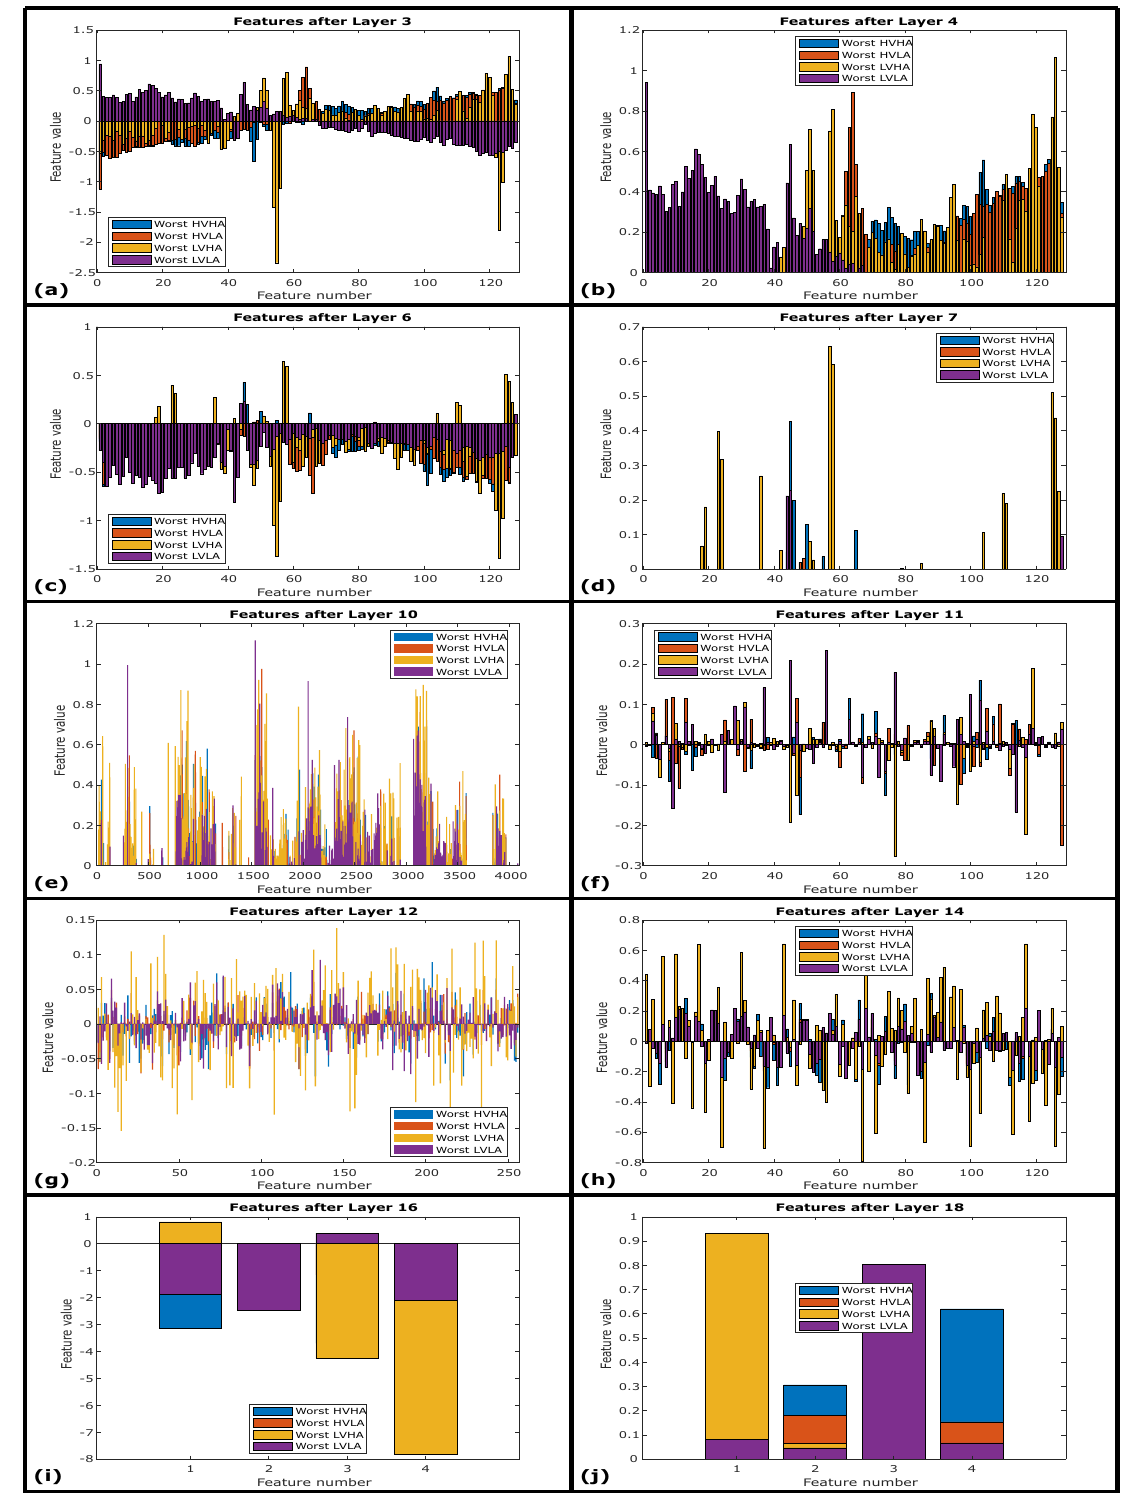
Figure 11. ( a ) Worst class-wise features after first convolution layer. ( b ) Worst class-wise features after first ReLU layer. ( c ) Worst class-wise features after second convolution layer. ( d ) Worst class-wise features after second ReLU layer. ( e ) Worst class-wise features after flatten layer. ( f ) Worst class-wise features after LSTM layer. ( g ) Worst class-wise features after FC1 layer. ( h ) Worst class-wise features after FC2 layer. ( i ) Worst class-wise features after FC3 layer. ( j ) Worst class-wise predictions after SoftMax